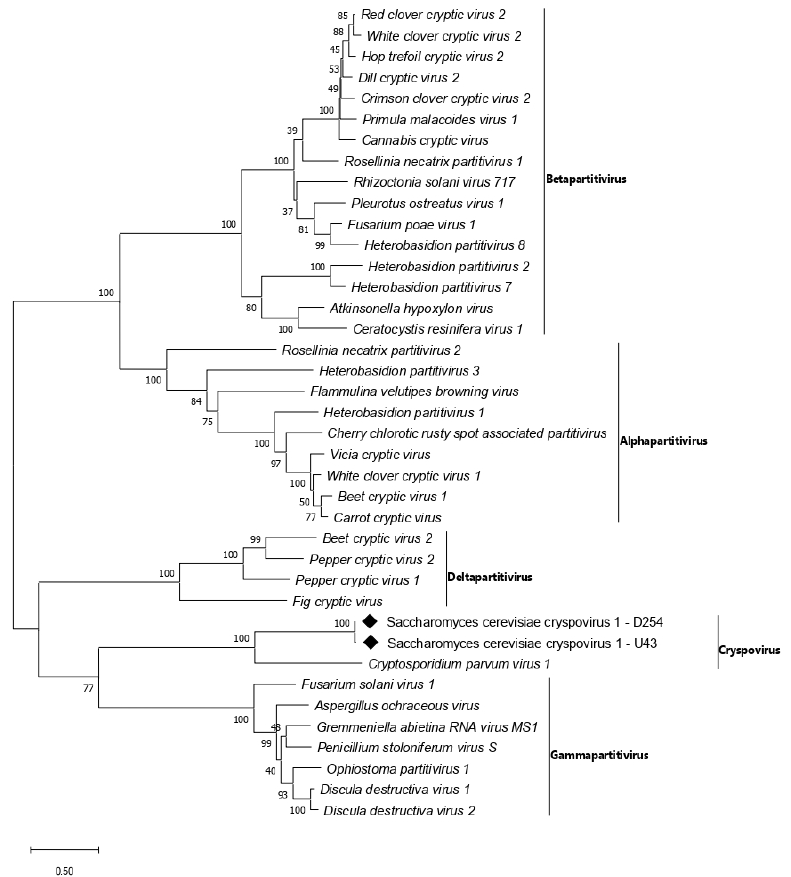
Figure 2. Phylogenetic analysis of Saccharomyces cerevisiae cryspovirus 1 isolates D254 (ScCV1-D254) and Saccharomyces cerevisiae cryspovirus 1 isolate U43 (ScCV1-U43). Maximum-likelihood tree was constructed based on the alignment of RdRp amino acid sequences. Bootstrap values reported at the nodes are from 1000 replicates. Sequences determined in this work are indicated by (cid:7)